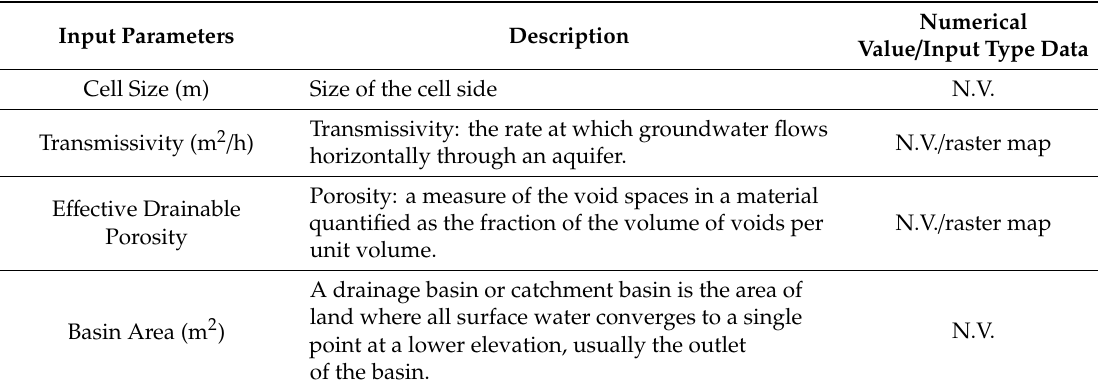
Table 2. Model data